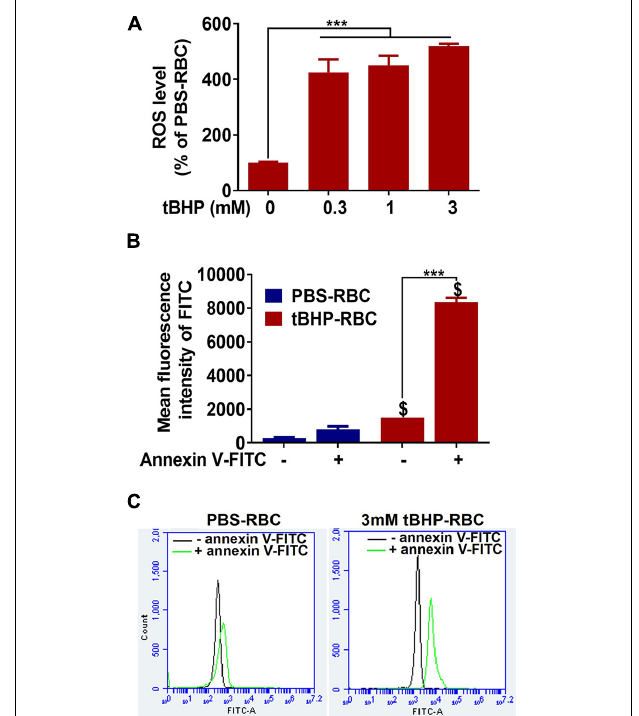
FIGURE 1 | ROS production and phosphatidylserine exposure in PBS- or tBHP-RBCs. ROS level (A) and phosphatidylserine exposure (B,C) were measured by H 2 DCFDA and annexin-V-FITC, respectively, after a 30-min incubation with PBS or tBHP. Data are presented as mean ± SEM of three independent experiments done in duplicate. One-way (A) or two-way (B) ANOVA with Holm–Sidak post hoc test was used. *** p < 0.001. $ p < 0.05 compared with the corresponding PBS-RBC